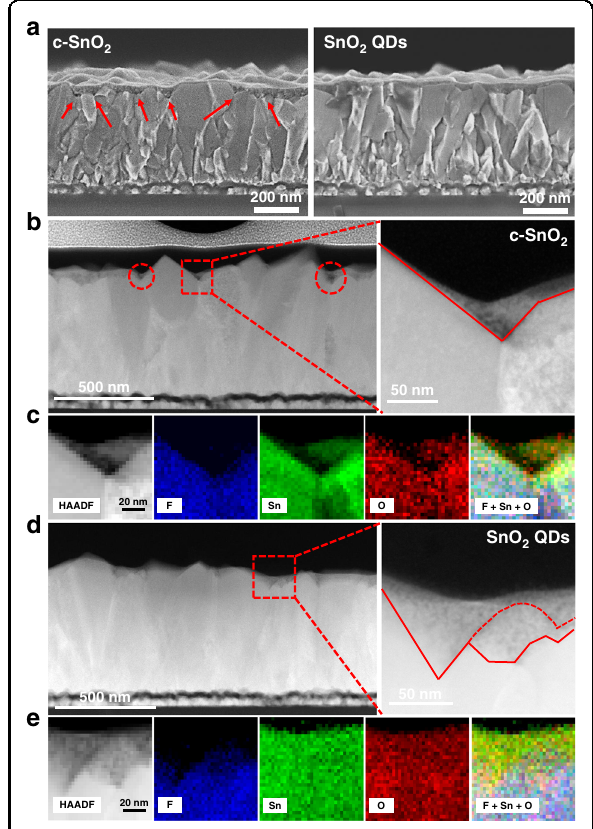
Fig. 2 Cross-sectional morphology of ETL coated FTO. a SEM cross-sectional image of c-SnO 2 -coated FTO (left) and SnO 2 QDs- coated FTO (right). HAADF-STEM cross-sectional image (left) and zoom-in image of the selected area (right) of b c-SnO 2 -coated FTO and c SnO 2 QDs-coated FTO. HAADE-STEM-EELS cross-sectional element mapping of d c-SnO 2 -coated FTO and e SnO 2 QDs- coated